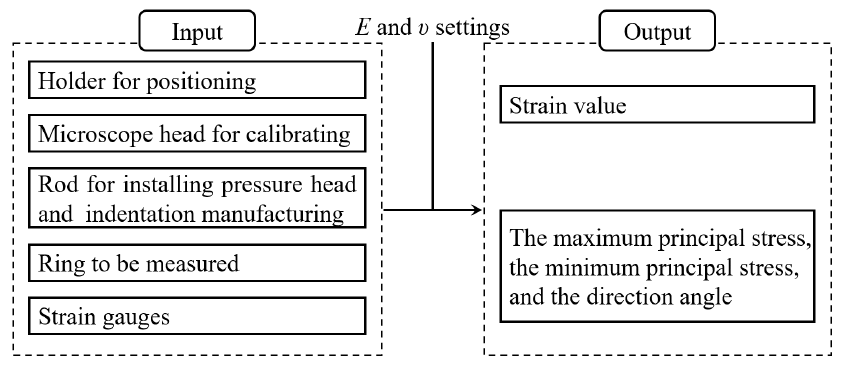
Figure 1. Block scheme of experimental system.